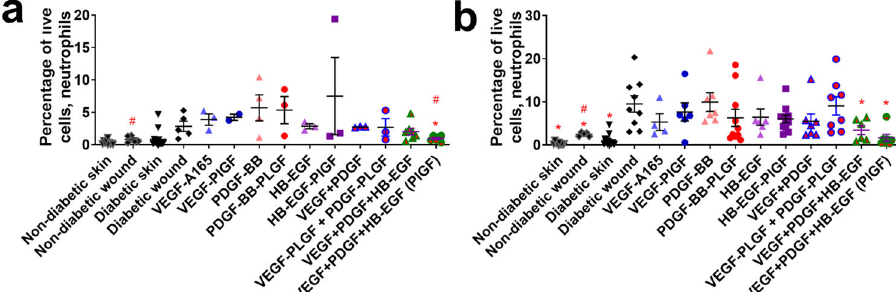
Fig. 3 Neutrophil (CD45 + , CD11b + , CD11c − , Ly6G + ) count in wounds after 3 – 7 days of healing. a 3 days, b 7 days. Comparison includes unwounded skin from both the NOD and NOR mice. n ranges from 3 to 20. * Denotes comparison to the diabetic wound. # Denotes a comparison between untreated NOD wound and untreated NOR wound, and the WT GF(s) are compared to their counterpart placental growth factor (-PLGF-2 123 – 144 ) variant(s), e.g., VEGF vs VEGF- PlGF-2 123 – 144 . * p < 0.05, p < 0.01, p < 0.001, Kruskal-Wallis + Mann-Whitney post